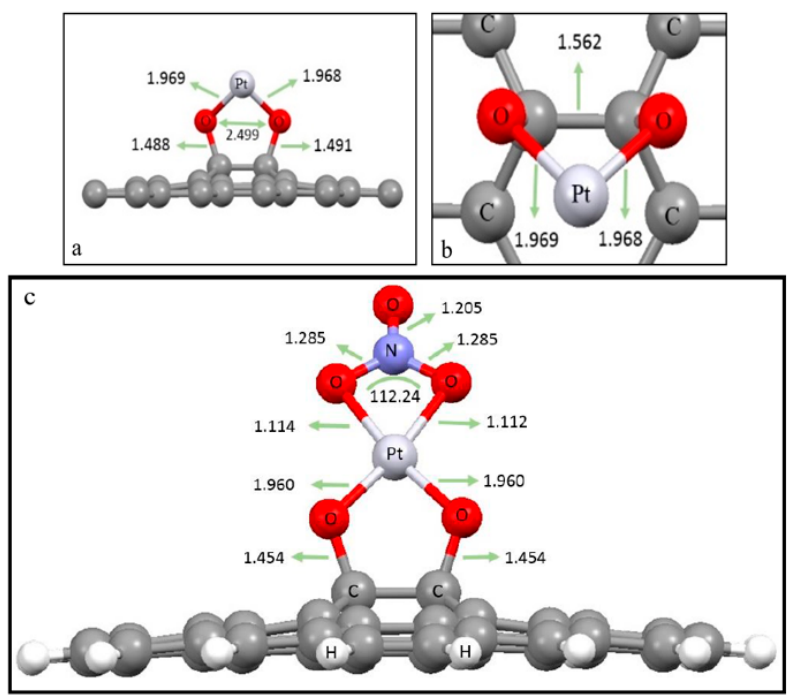
Figure 1. ( a ) Side and ( b ) top views of the optimum position of Pt nanoparticles on GO, and ( c ) the optimized nitrate interaction with the surface of GO/Pt. The bond lengths are represented in Å (angstrom) units.